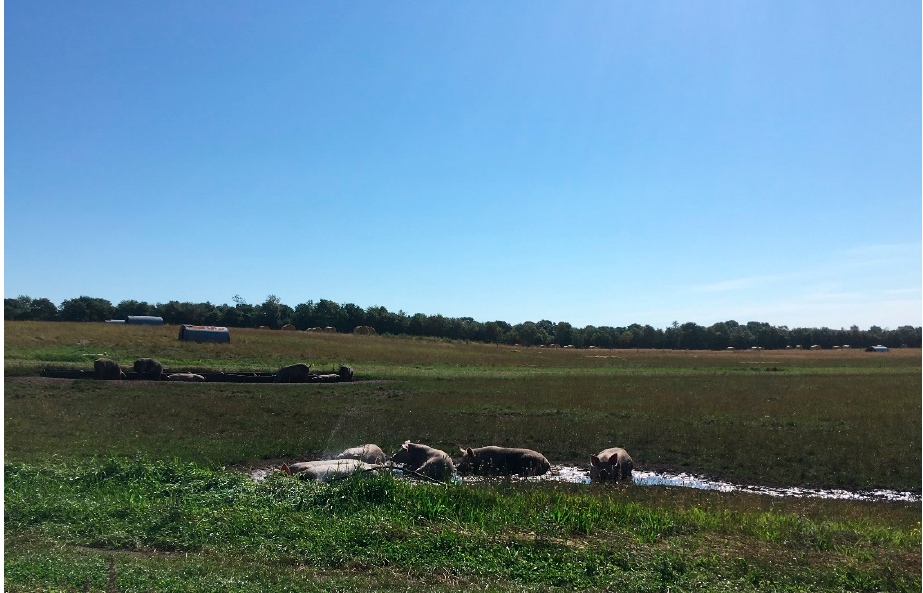
Figure 1. Organic outdoor gestating sows resting in their mud hole on a sunny day.